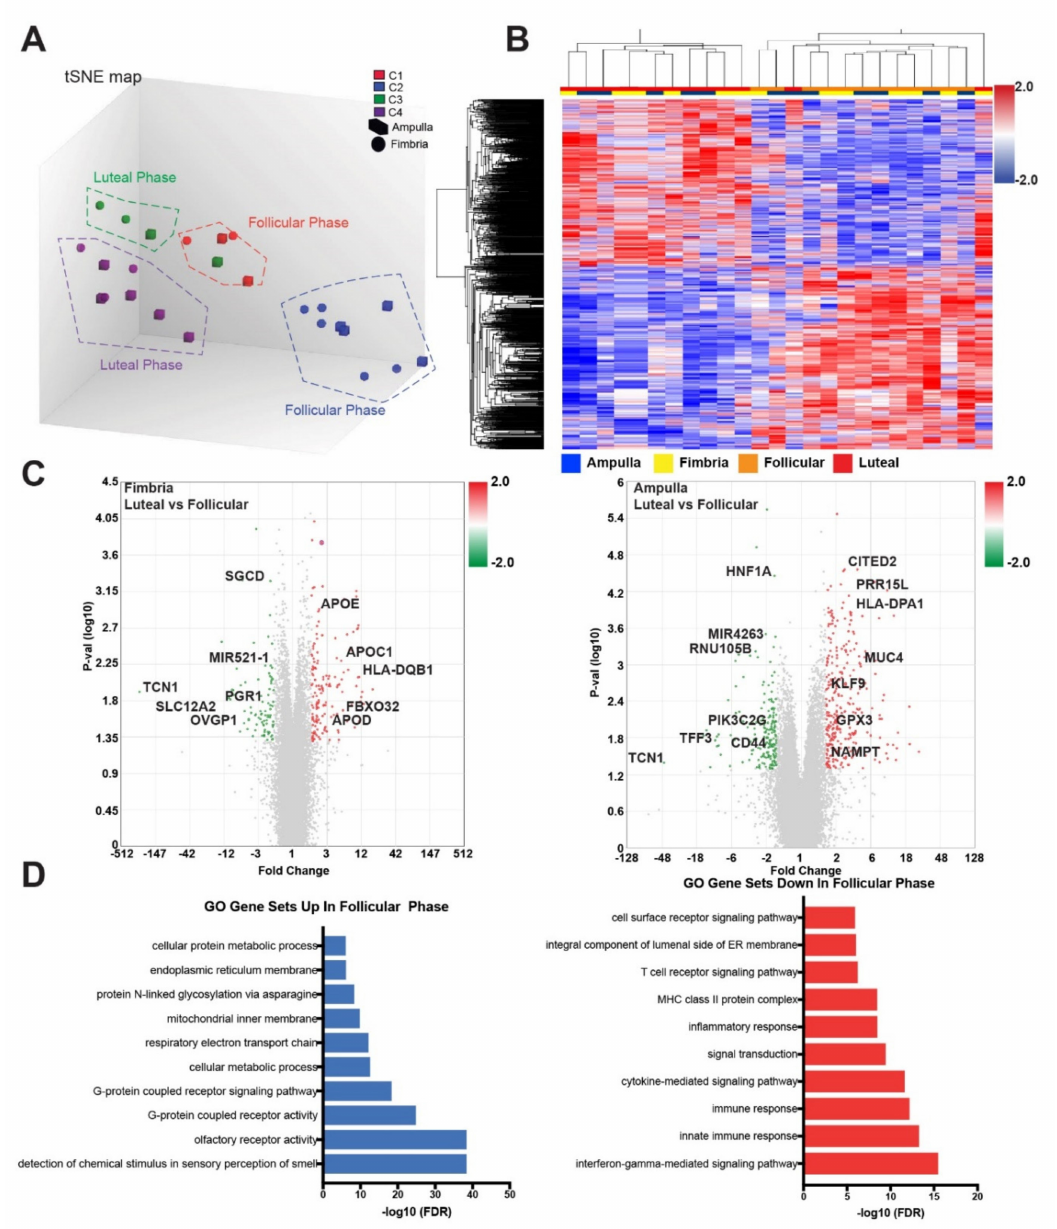
Figure 2. Transcriptional analysis shows distinct di ff erences between the luteal and follicular phase with cases self-clustering according to ovulatory cycle. ( A ) tSNE plot of cases, generated using Ingenuity Pathway Analysis software, showed self-clustering groups according to ovarian cycle phase. C1, C2, C3 and C4 represent clusters of cases that group together according to similarity of gene e ff ects across the ovarian cycle phases (luteal vs. follicular). ( B ) Heat map of the gene-level expression di ff erences between the follicular and luteal phases ( p = 0.01). ( C ) Volcano plot of the luteal versus follicular comparison in fimbria and ampulla ( p < 0.05). ( D ) Gene Ontology (GO) gene set analysis shows top processes upregulated and downregulated in the follicular phase compared to the luteal phase of the ovarian